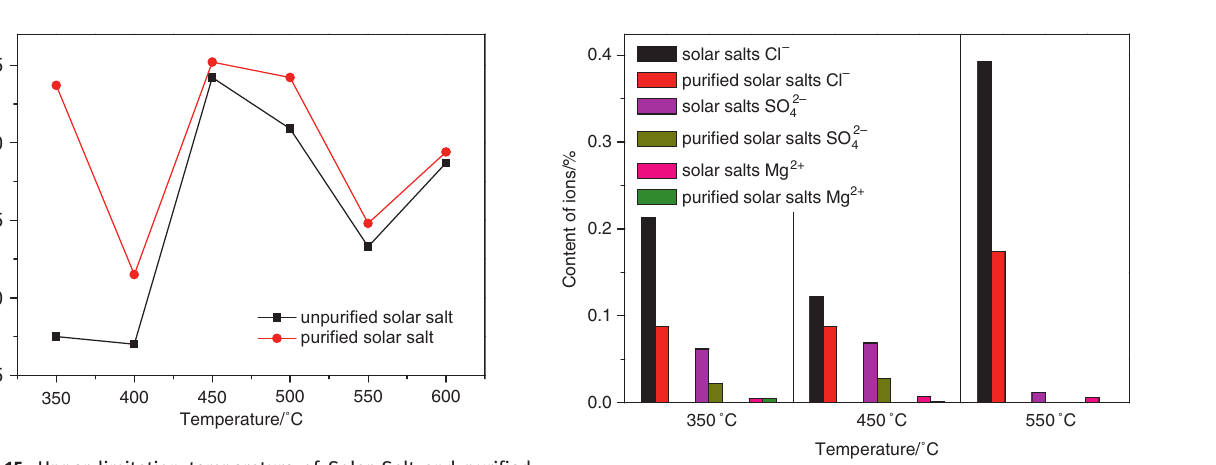
Figure 16: Content of impurities of Solar Salt and purified Solar Salt after 27 h 3.6 XRD analysis.